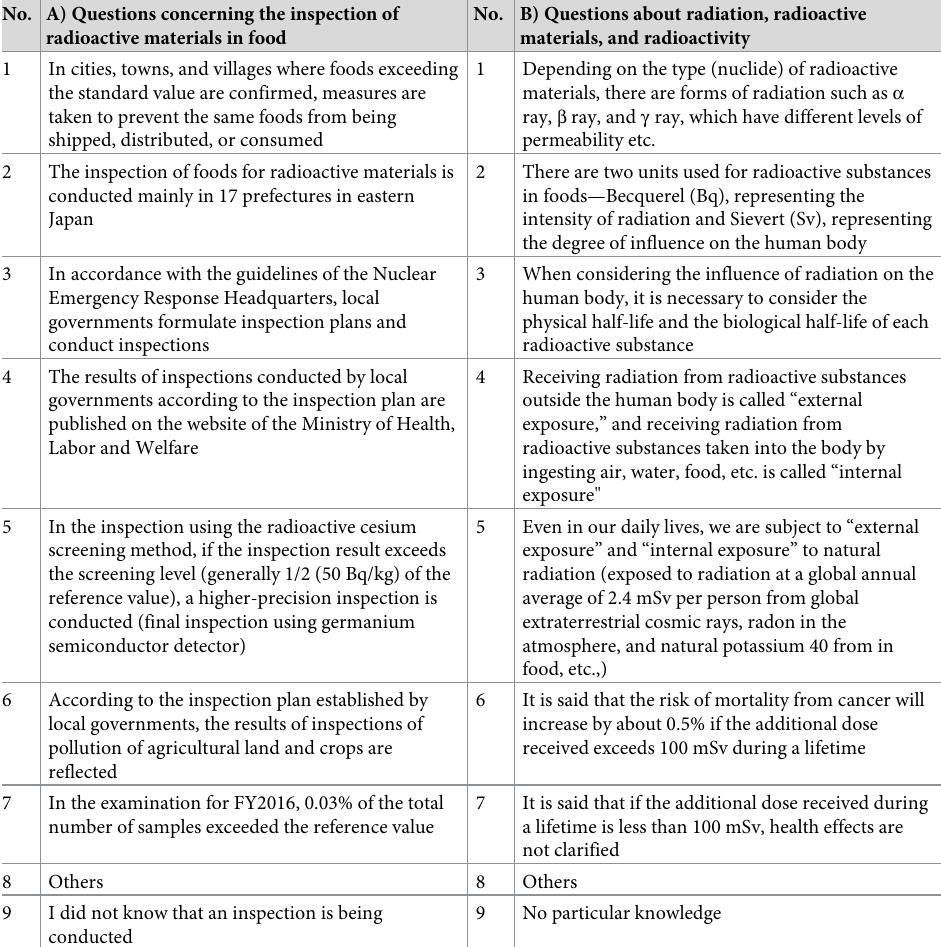
Table 2. Questionnaire about